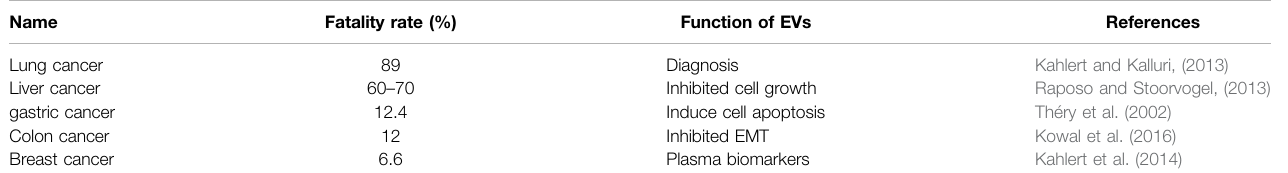
TABLE 1 | The function of EVs in cancers.